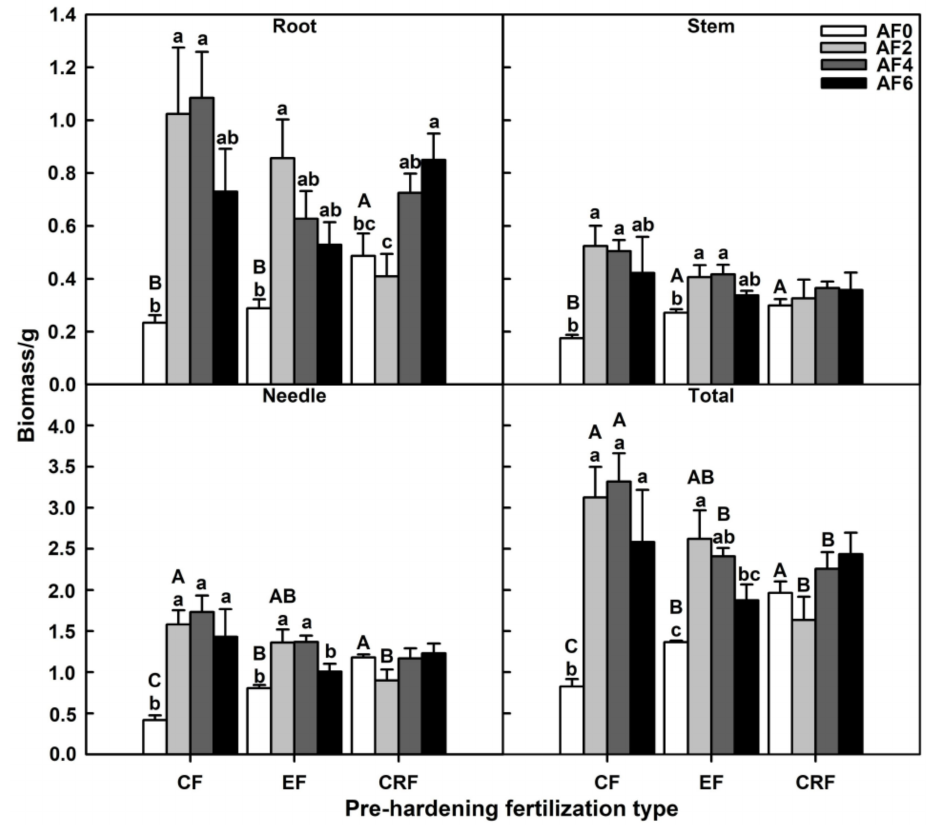
Figure 1. Root, stem, needle, and total biomass in seedlings of Pinus koraiensis in response to pre- hardening fertilization type (CF, EF, and CRF) and autumn fertilization level (AF0, AF2, AF4, and AF6) treatments. Bars and arrows represent the mean and corresponding standard error, respectively. Different capital letters indicate a significant effect of biomass among pre-hardening fertilization types ( p < 0.05). Different lowercase letters indicate significant differences in biomass among autumn fertilization levels ( p < 0.05). Means were compared using Duncan’s